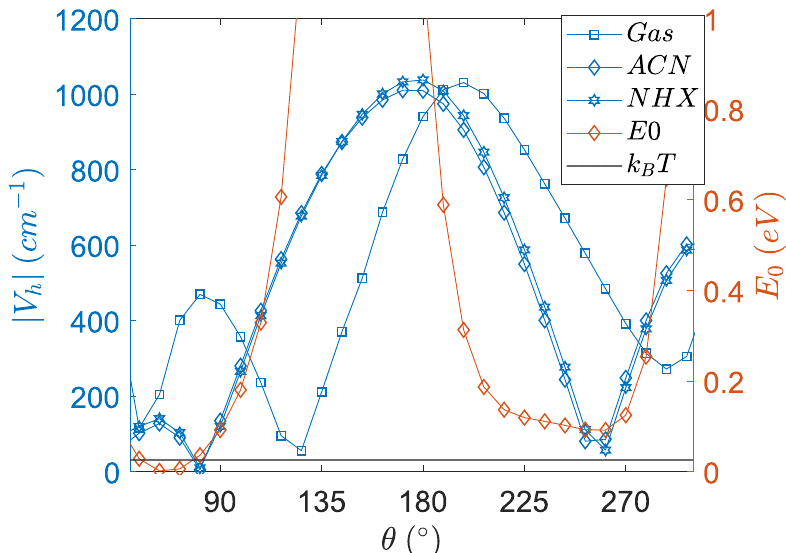
Figure 9. The electronic coupling as function of the dihedral angular coordinate. The calculations are performed starting with the S 2 geometry in different solvents (PBE/TZP). The electronic coupling is calculated with a TZP basis and the CAM-B3LYP XC functional using the fragment method. The ground state energy (E 0 ) in NHX of the intact molecule alongside the thermal energy ( k B T) is plotted to indicate the important range of conformations for the whole intact PyrDMA molecule. The black horizontal line represents the thermal energy available in the ground state. Note that the x -axis ranges from 45 to 300 degrees.